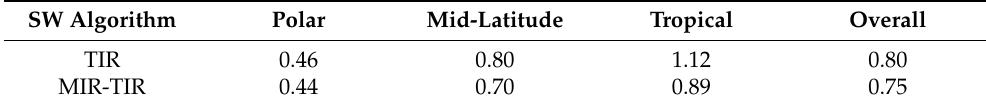
Table 2. LST RMSEs of two SW algorithms for different